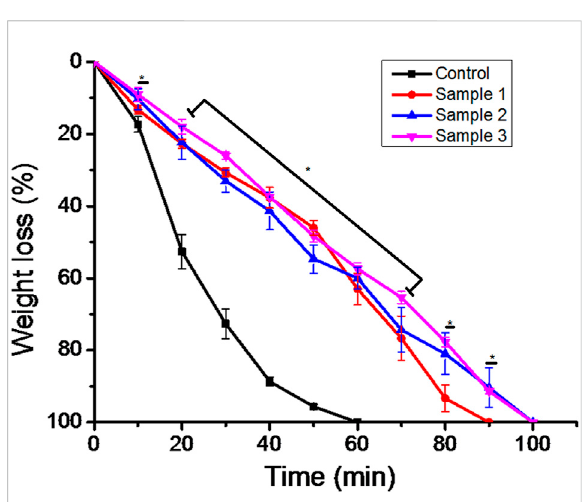
FIGURE 6 In vitro biodegradation of the bio-polymeric beads, including control and ESMP-modi fi ed samples, indicating weight loss in the non-enzymatic system of 1X PBS. Here, * indicates the signi fi cant difference between samples ( p <